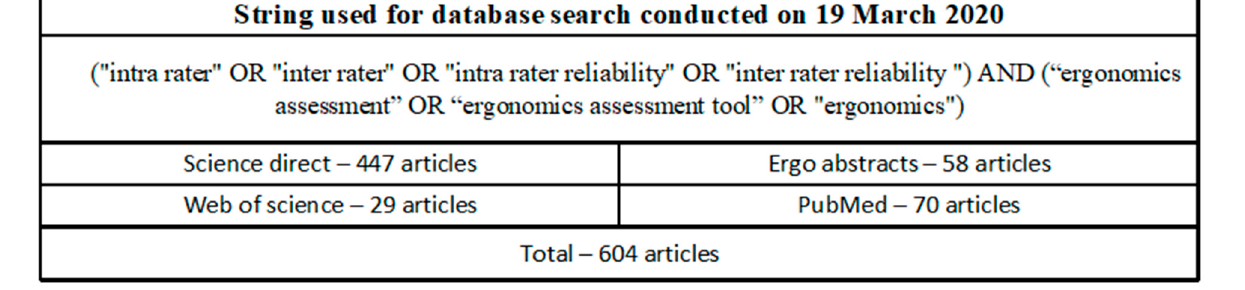
Figure 1. Search string used in the review.